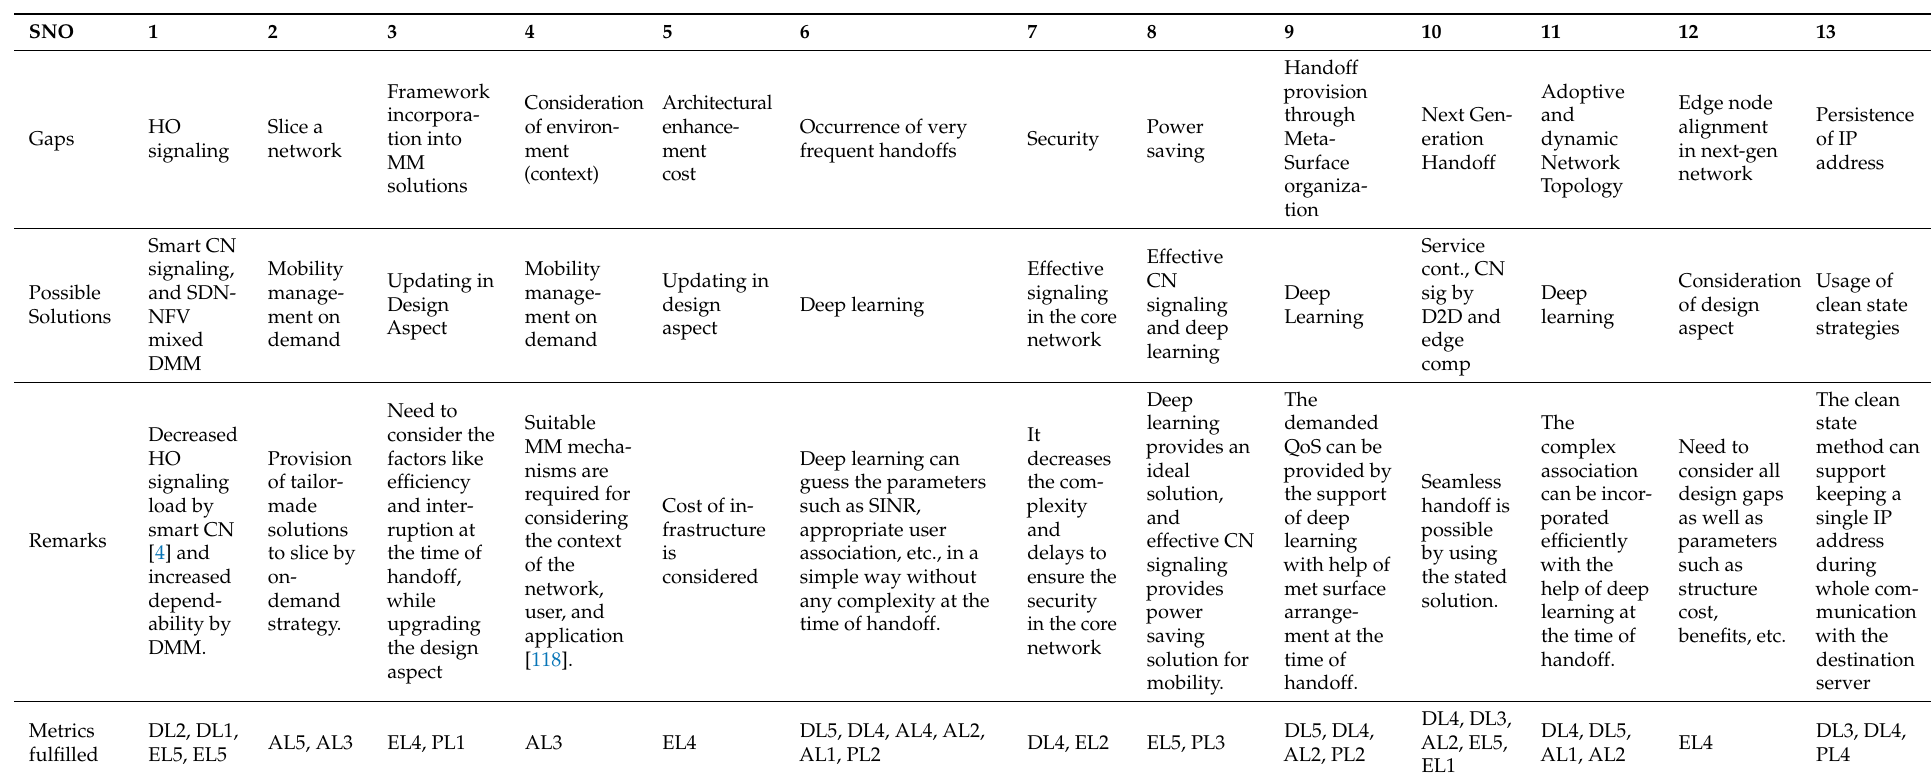
Table 5. MM mapping of possible solutions to gaps/problems (mapping from Table